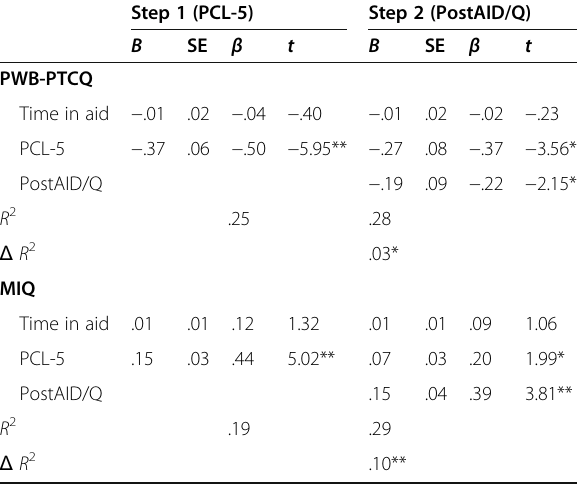
Table 4 Hierarchical regression analysis of predictors of psychological well-being and moral injury Step 1